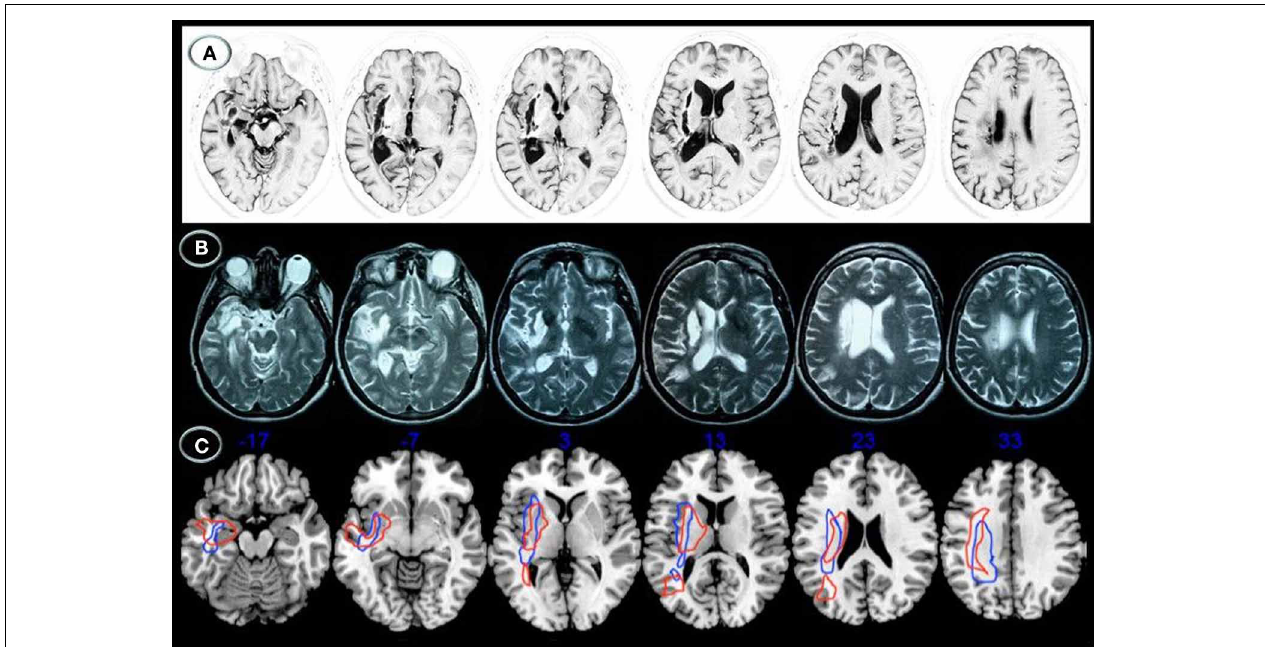
FIGURE 1 | Structural axial MRI of patients JAM (A) and AFL (B) showing the full extension of lesions. A 3T MRI (Short T 1 Inversion Recovery—STIR—sequence) in JAM and 1.5T MRI (T2-weighted sequence) in AFL show relatively similar lesion topographies involving the right striatocapsular region with inferior extension to the temporal stem, ventral